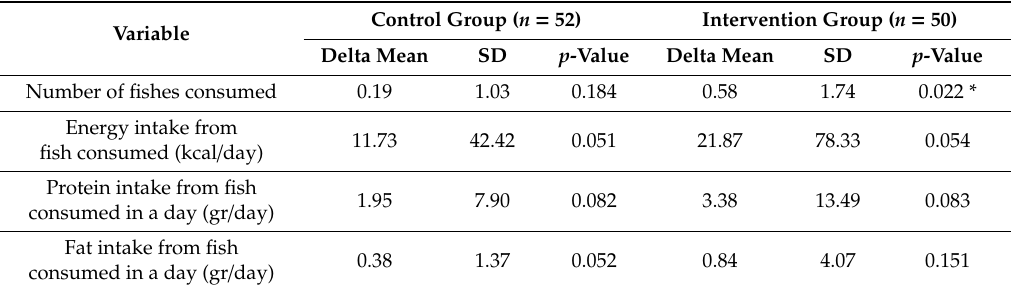
Table 7. Change in children’s fish consumption after 3 months intervention.